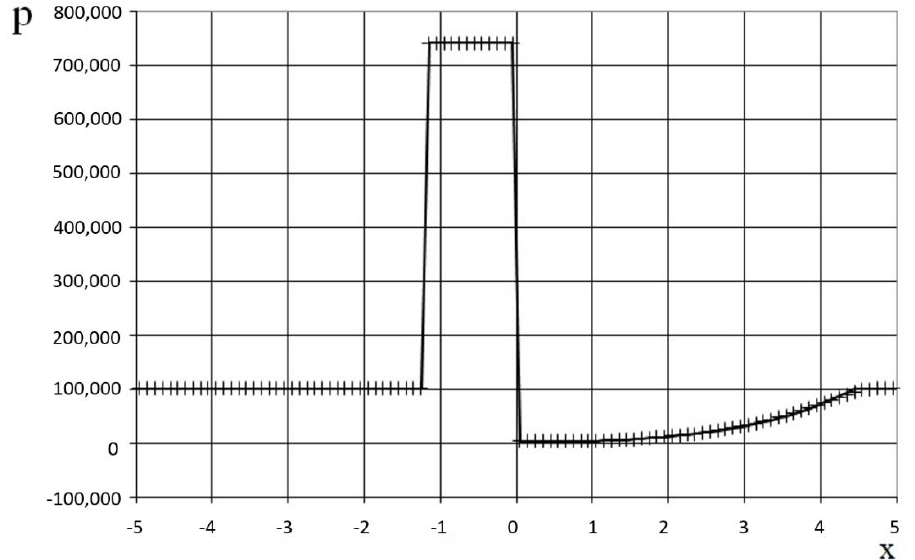
Figure 31. Pressure plot for the problem (54): the exact solution (line), and the present method (cross).